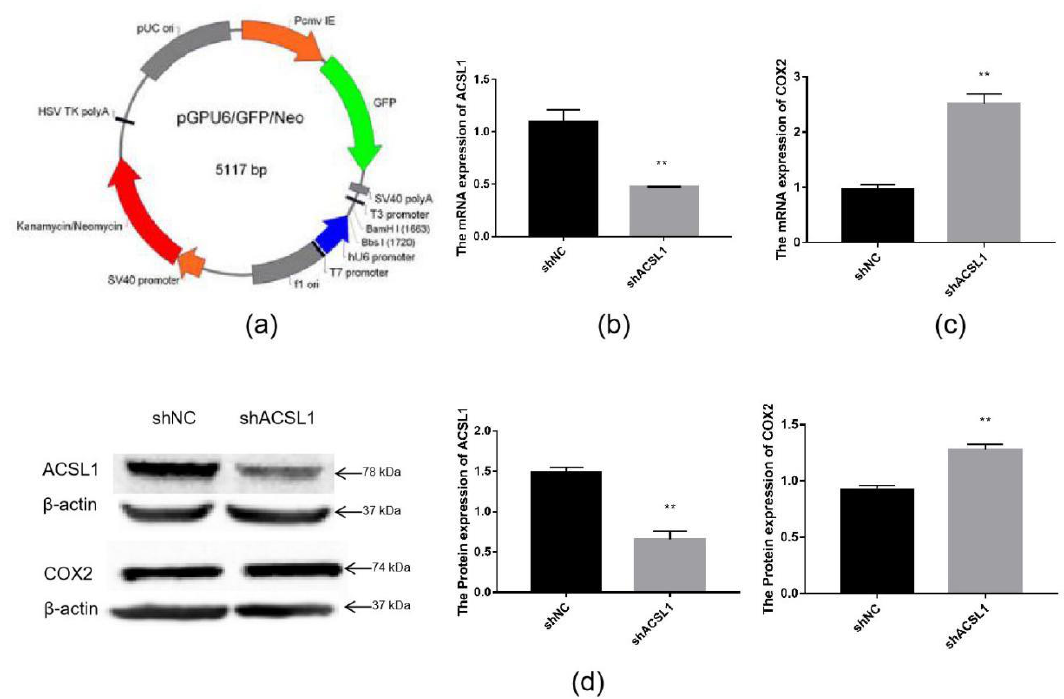
Figure 6. Knockdown of the ACSL1 gene in sheep preadipocytes: ( a ) the pGPU6 vector; ( b ) ACSL1 mRNA expression on day 8 of di ff erentiation (** p < 0.01); ( c ) COX2 mRNA expression on day 8 of di ff erentiation (** p < 0.01); ( d ) ACSL1 and COX2 protein expression on day 8 of di ff erentiation (** p < 0.01). shNC: Adipocytes transfected with shNC as control. shACSL1: Adipocytes transfected with shRNA-1928 of the ACSL1 gene. Int. J. Mol. Sci. 2020 , 21 , x FOR PEER REVIEW